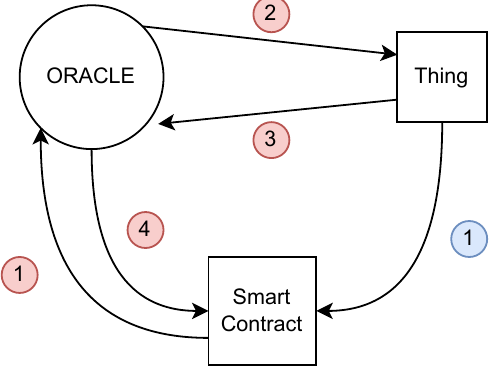
Figure 5. Methods of interaction of an IoT device with the blockchain. When the thing pushes data into the blockchain, it can autonomously start a transaction (1). In all the cases where a smart contract needs to access data available on a thing, it has to make a request to an oracle (1) that collects the data from the thing (2 and 3) and makes them available for any subsequent request (4), guaranteeing